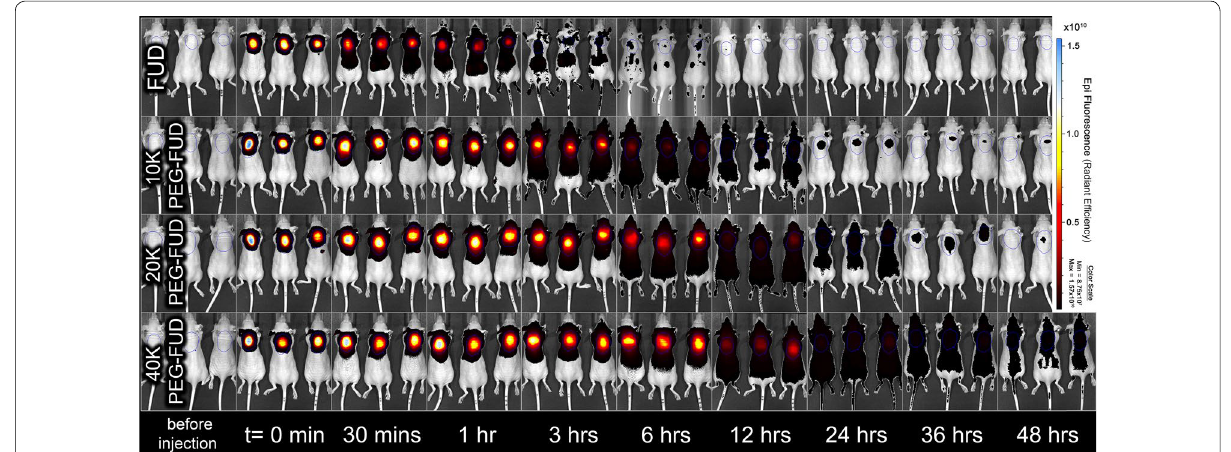
Fig. 7 In vivo fluorescence imaging of FUD and 10–40 kDa PEG-FUD remaining dose after s.c. administration of a dose containing the peptide and its sulfo-Cy5 conjugate between the shoulder blades of the mouse. A blue circle drawn between the shoulder blades of each animal indicates regions of interest (ROI) used to indicate the location of the dose to quantify the total remaining dose. Same scale (8.75 visualize the fluorescence intensity in all images